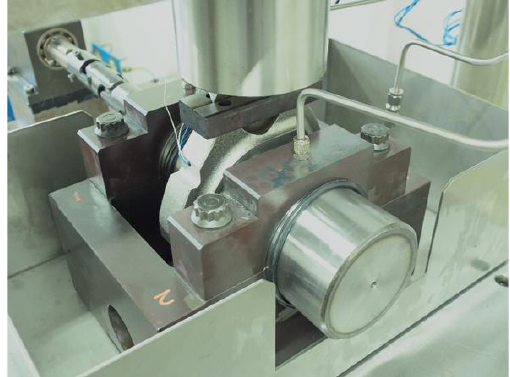
Figure 2. The component-level tribological test machine.